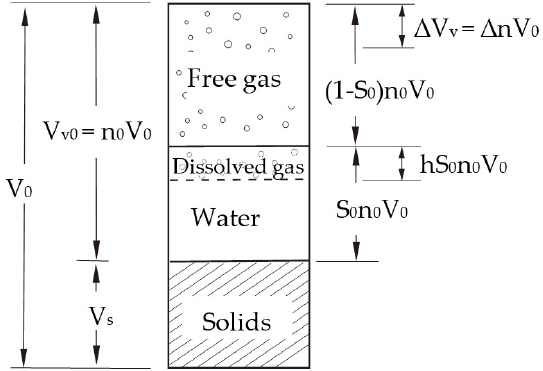
Figure 1. Volumetric composition of the gassy sand.